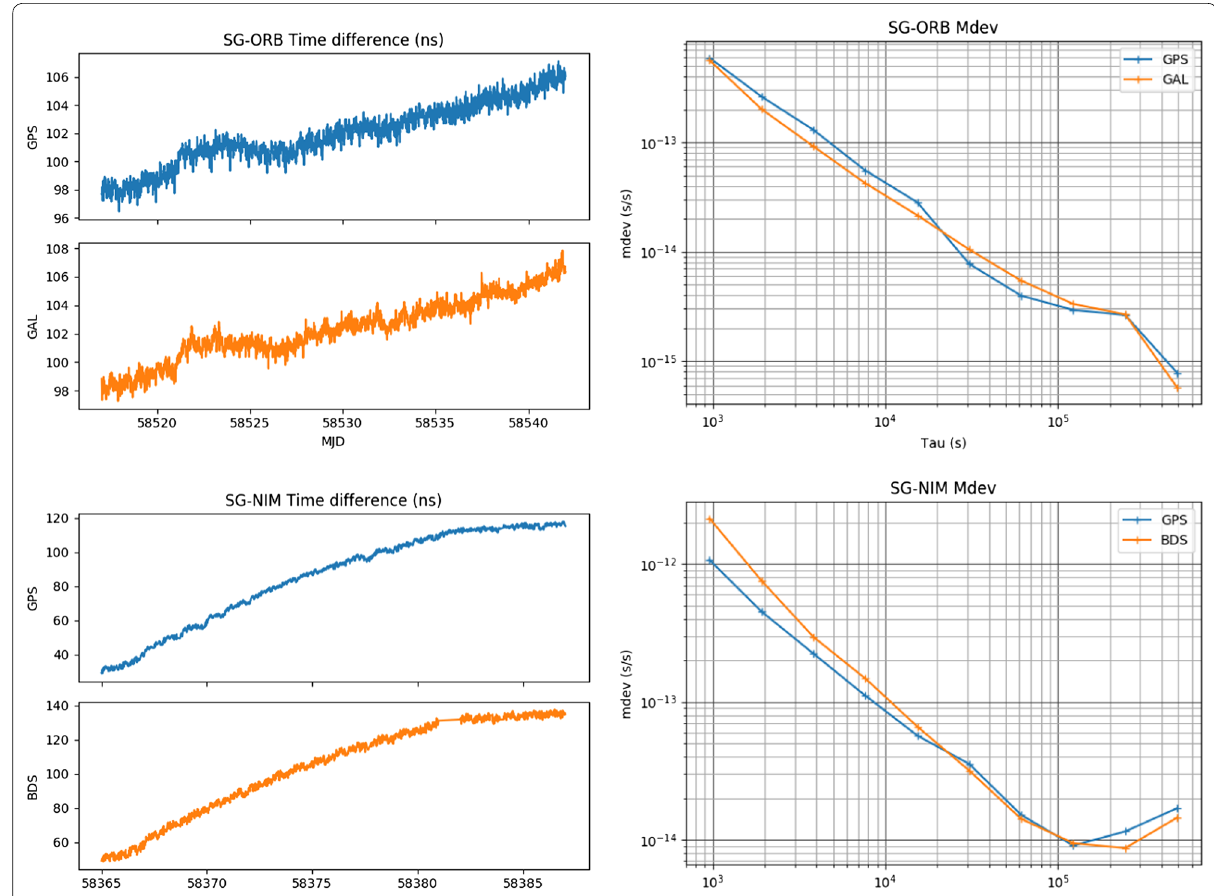
Fig. 5 Dual-frequency GPS and Galileo code-based time transfer for the 10,000 km link Singapore-Brussels and the corresponding Modified Allan deviation (Mdev) stability (above). Dual-frequency GPS and BeiDou 2 code-based time transfer for the 4500 km link Singapore-Beijing and the corresponding Mdev stability